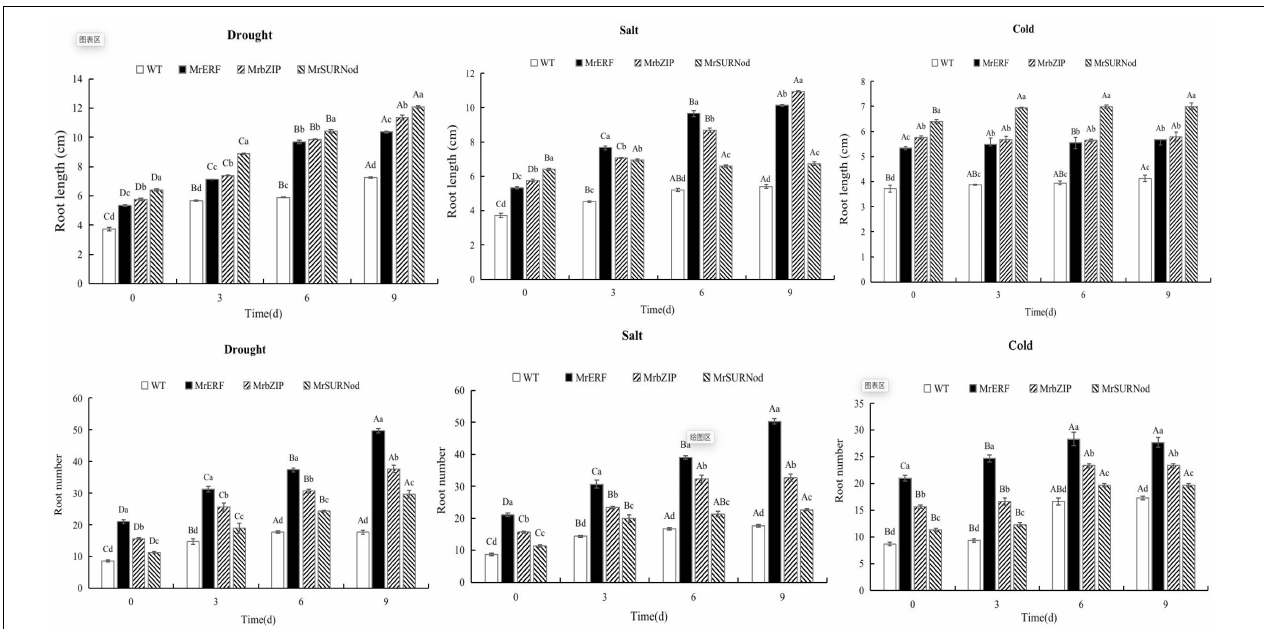
FIGURE 8 | Effects of different stresses on root growth of tobacco. Different capital letters indicate significant differences under different treatments, and different lowercase letters indicate significant differences among different transgenic lines in the same treatment ( P < 0.05).